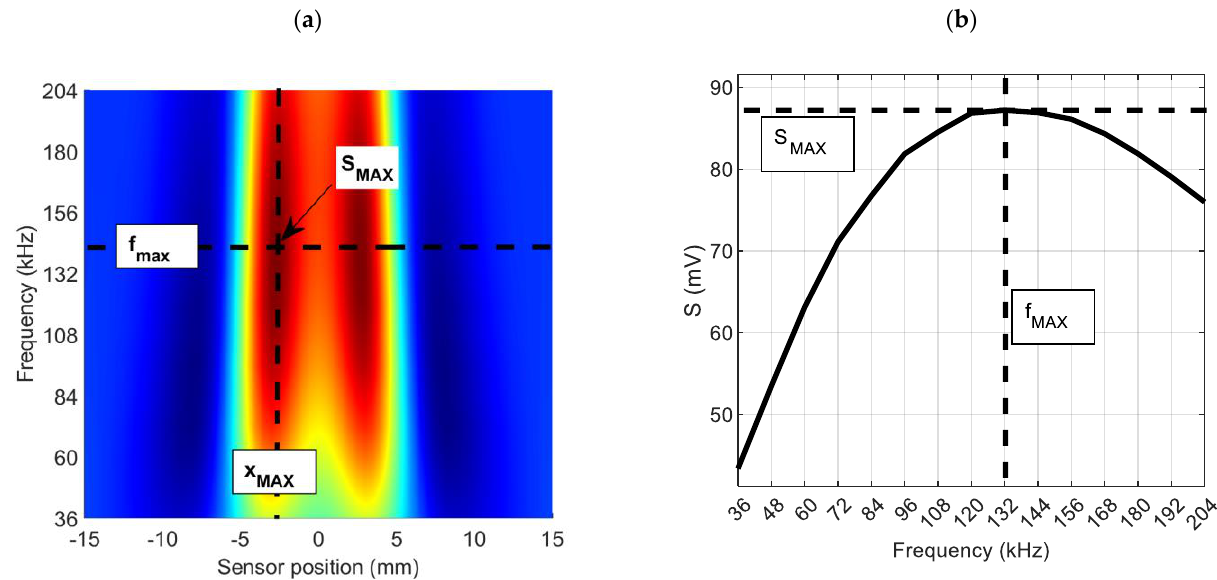
Figure 4. Spectrogram: the two-dimensional plot ( a ) and frequency characteristic for X MAX point ( b ) with marked parameters ( S MAX , f MAX ) corresponding to the material defect.